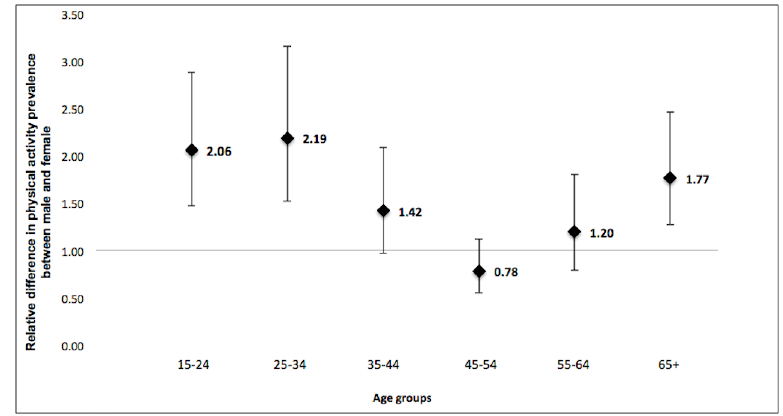
Figure 2. Relative difference in prevalence of recommended LTPA between males and females according to age groups.